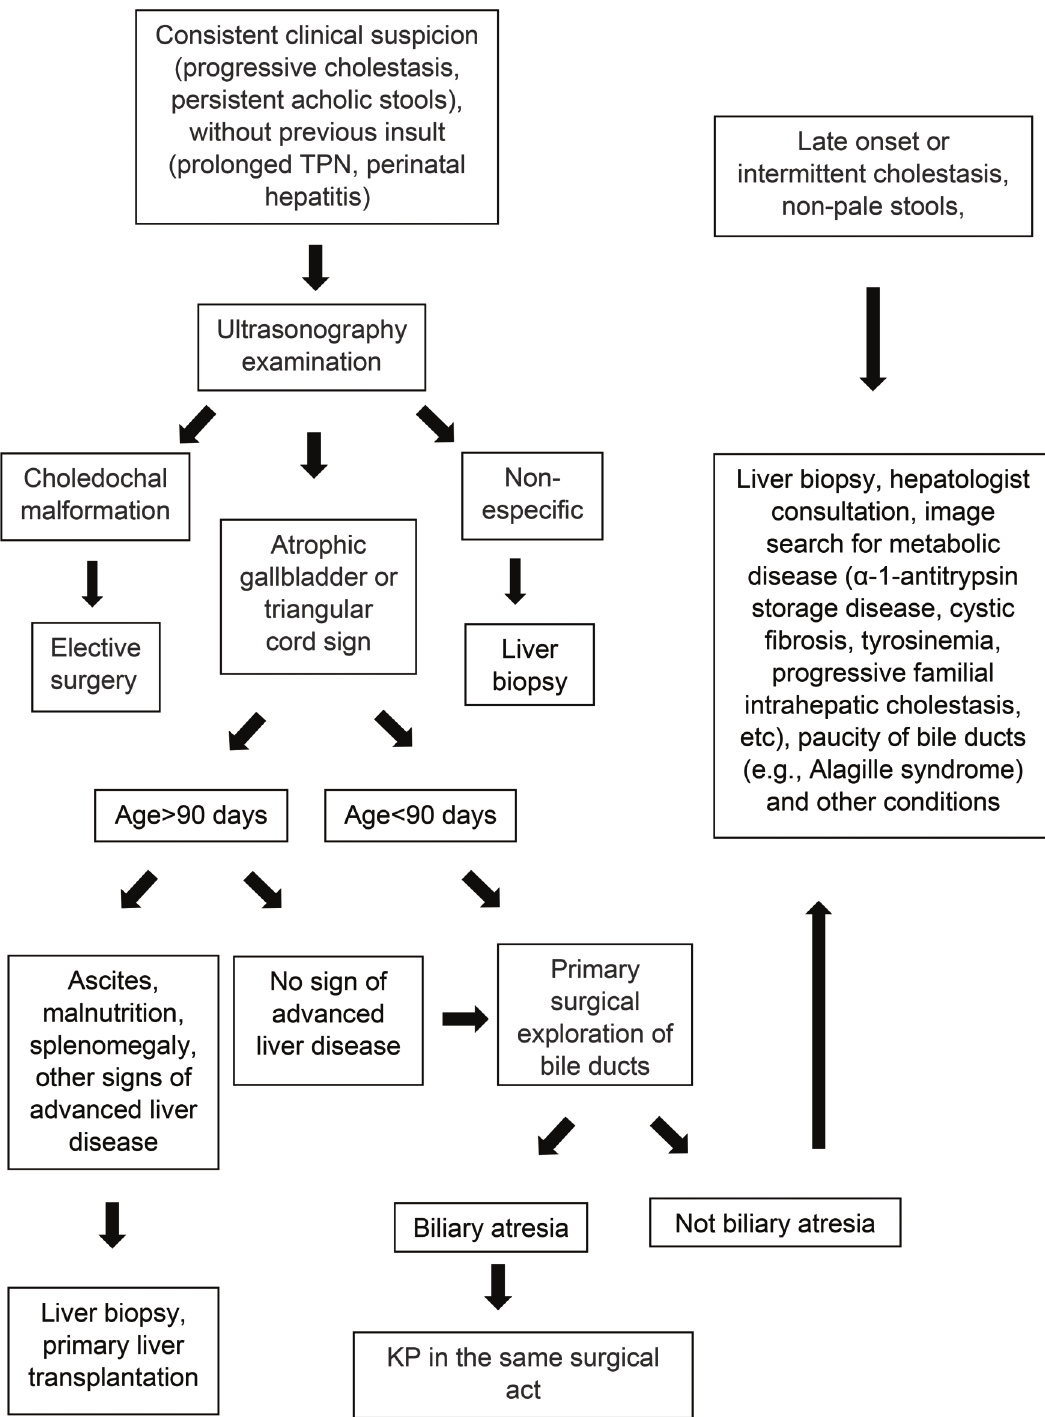
Figure 1 - Perinatal cholestasis flowchart (TPN – total parenteral nutrition; KP – Kasai